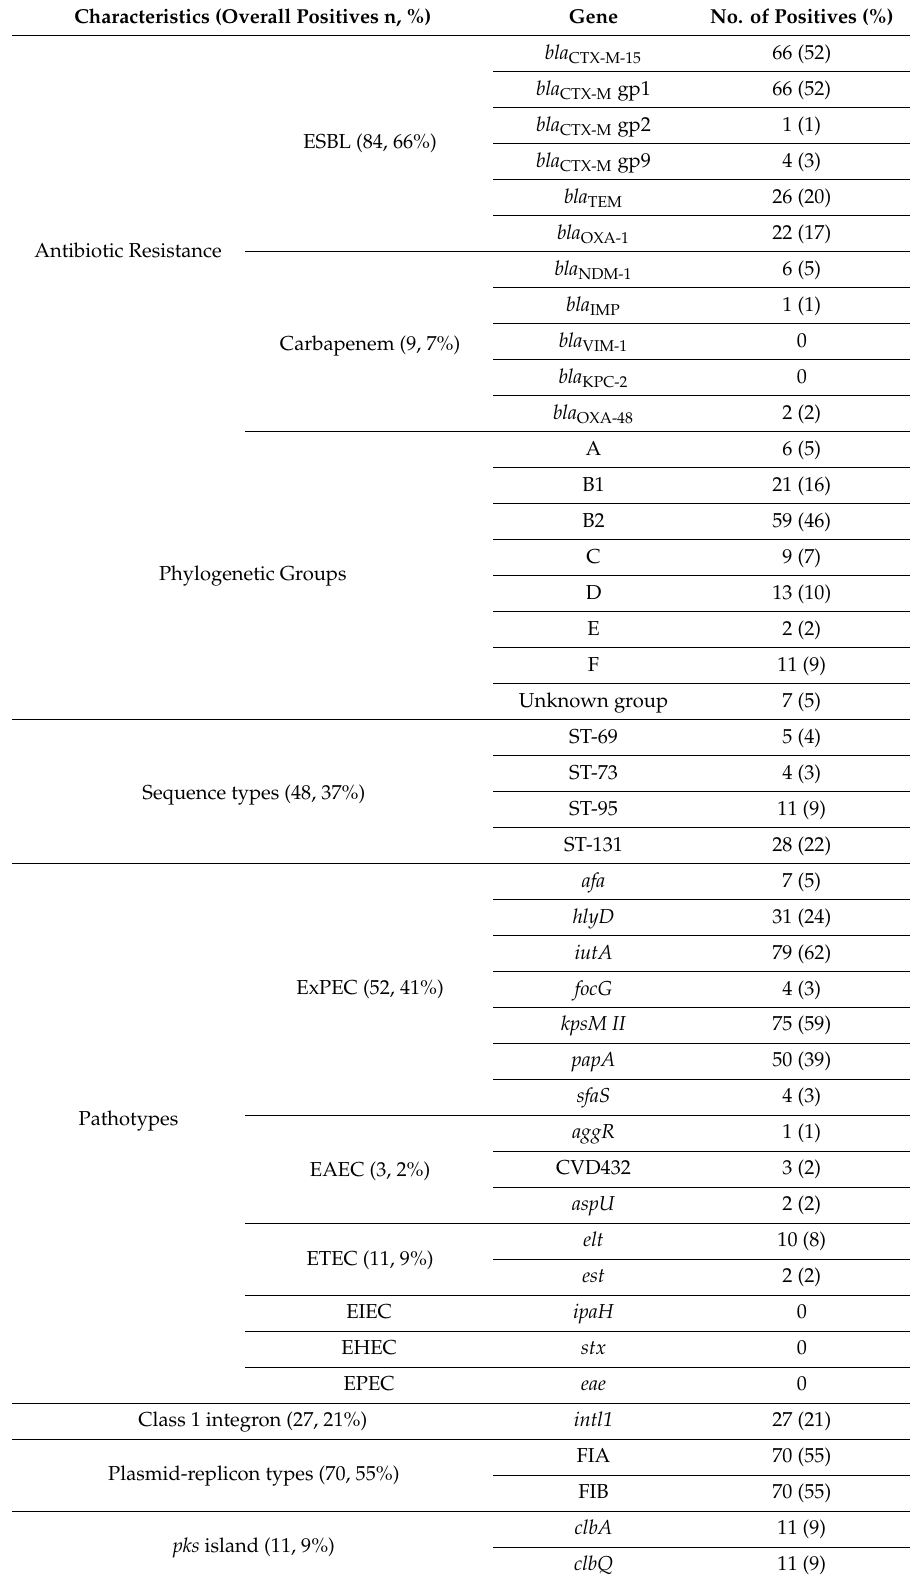
Table 2. Molecular characteristics of 128 E. coli isolates analyzed including antimicrobial resistance, virulence and phylogenetic